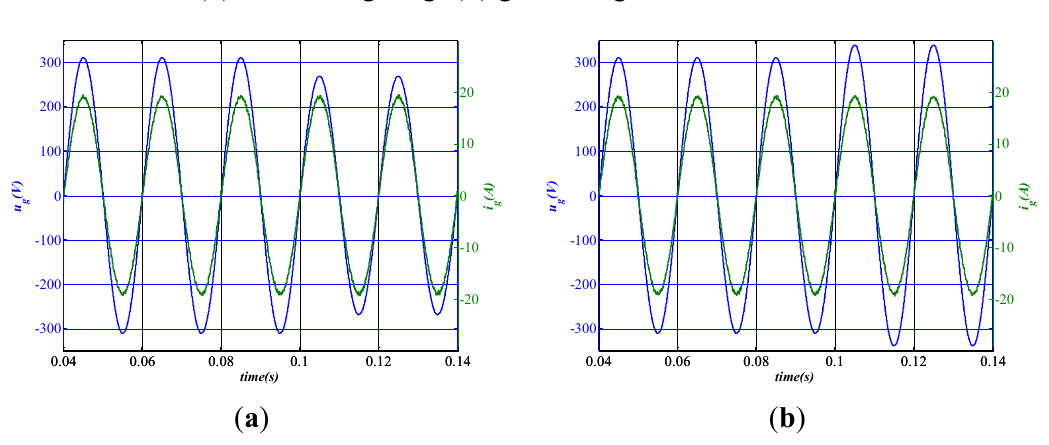
Figure 15. Grid voltage and injected current at full load with nominal parameters: simulation results. ( a ) Grid voltage sag; ( b ) grid voltage swell.